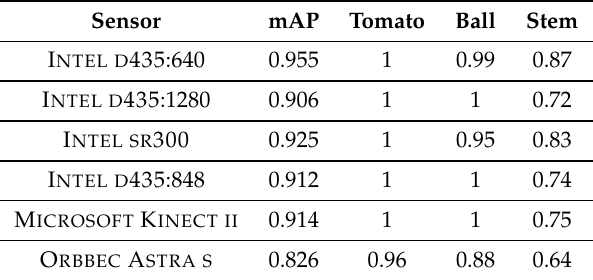
Table 3. mAP results for the object detection task using only RGB data.